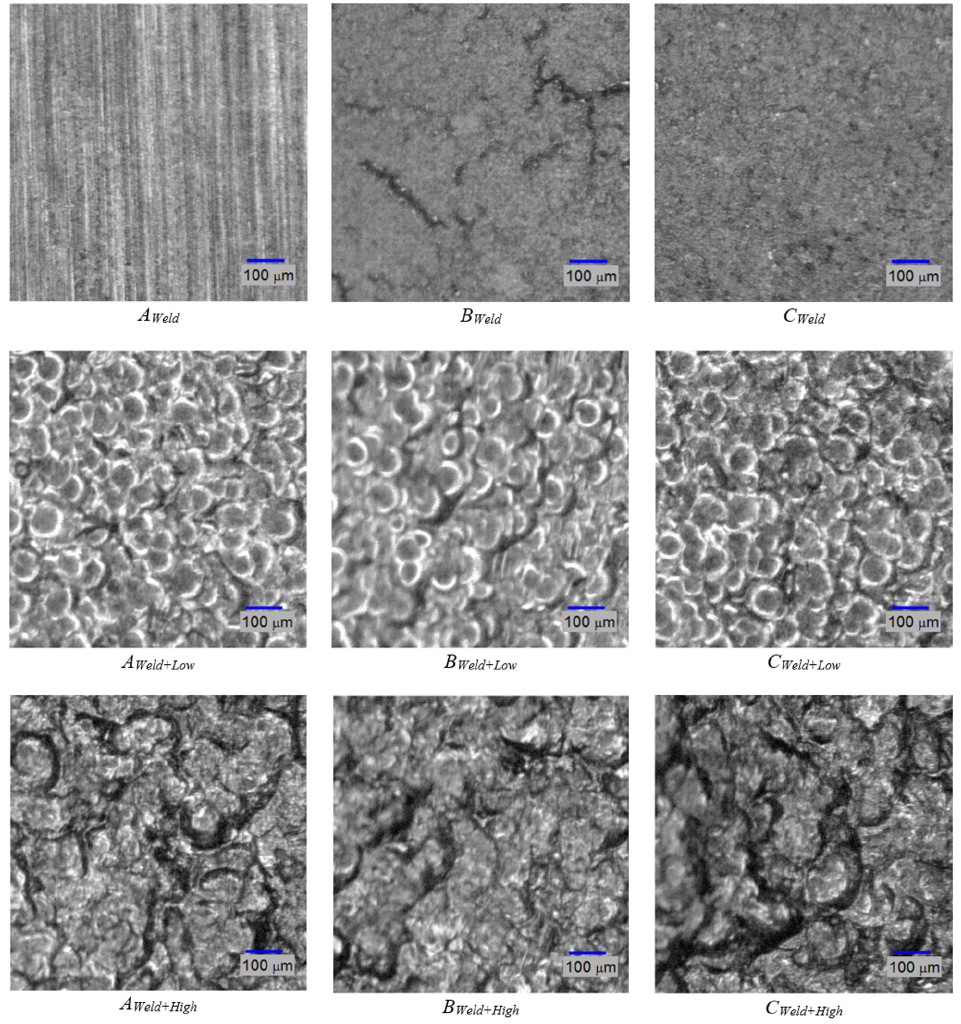
Figure 11. Grayscale images of three samples with three regions